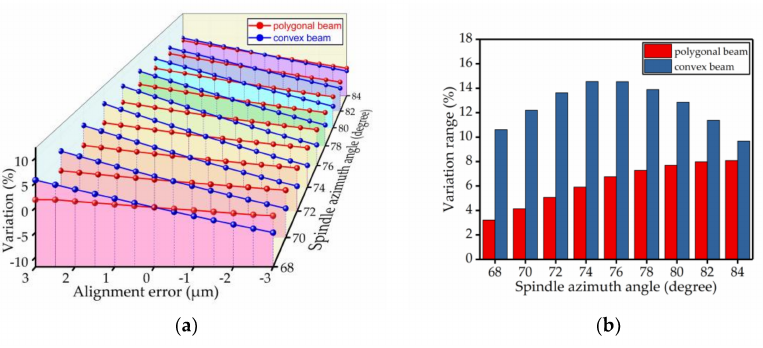
Figure 9. The influence of the alignment error on the spindle azimuth angle of the polygonal cross-section beam and convex cross-section beam; ( a ) shows the relationship between the spindle azimuth angle’s variation and the alignment error; ( b ) shows the range of variation—the value is the difference between the maximum and minimum value of each